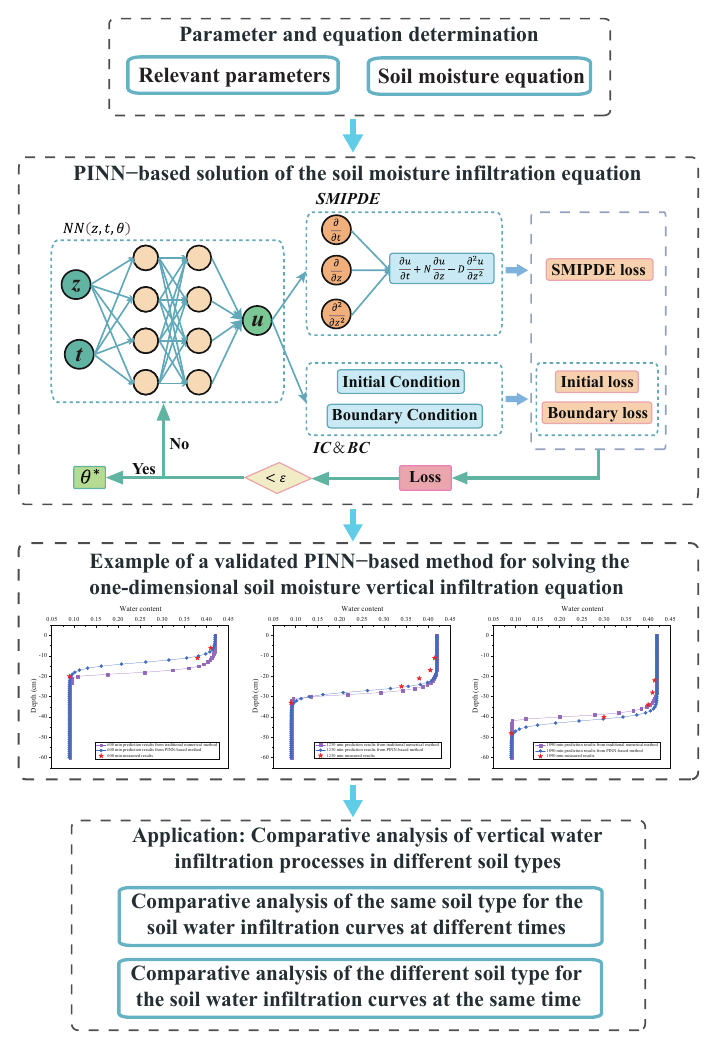
Figure 1. The workflow diagram of this